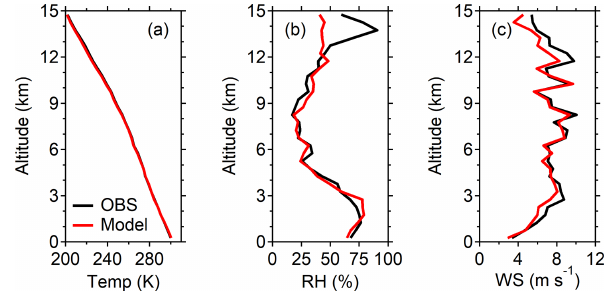
Figure A2. Comparison of (a) air temperature (Temp), (b) rela- tive humidity (RH), and (c) horizontal wind speed (WS) averaged from all flight measurements (OBS) and WRF-Chem simulations (Model).